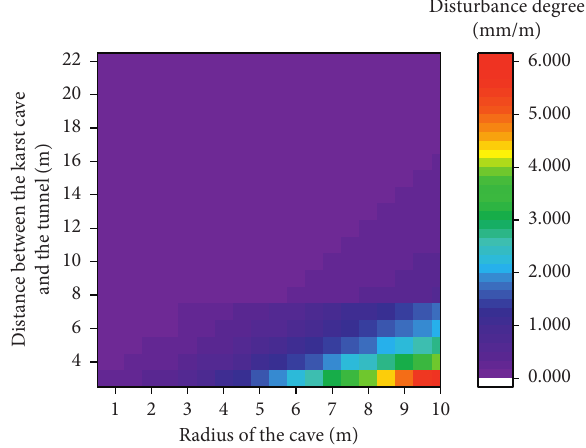
Figure 16: Heat map of the disturbance degree of the karst cave to the tunnel under all karst distribution